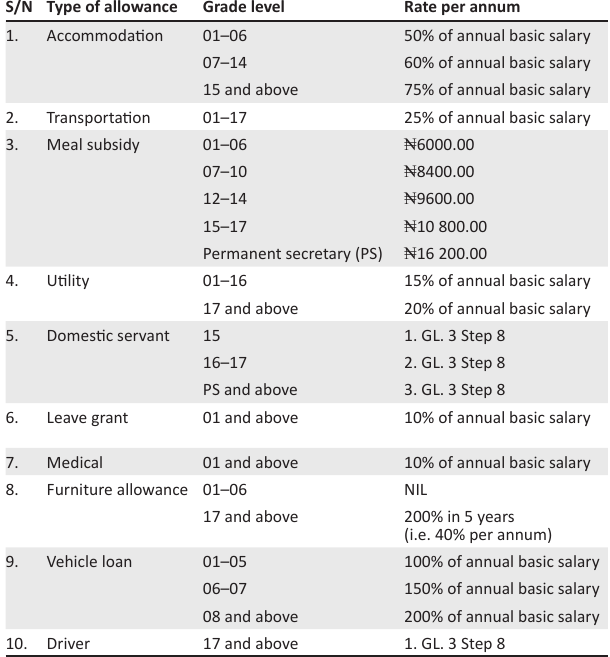
TABLE 1: Approved harmonised fringe benefits and allowances for federal civil servants under the Monetisation